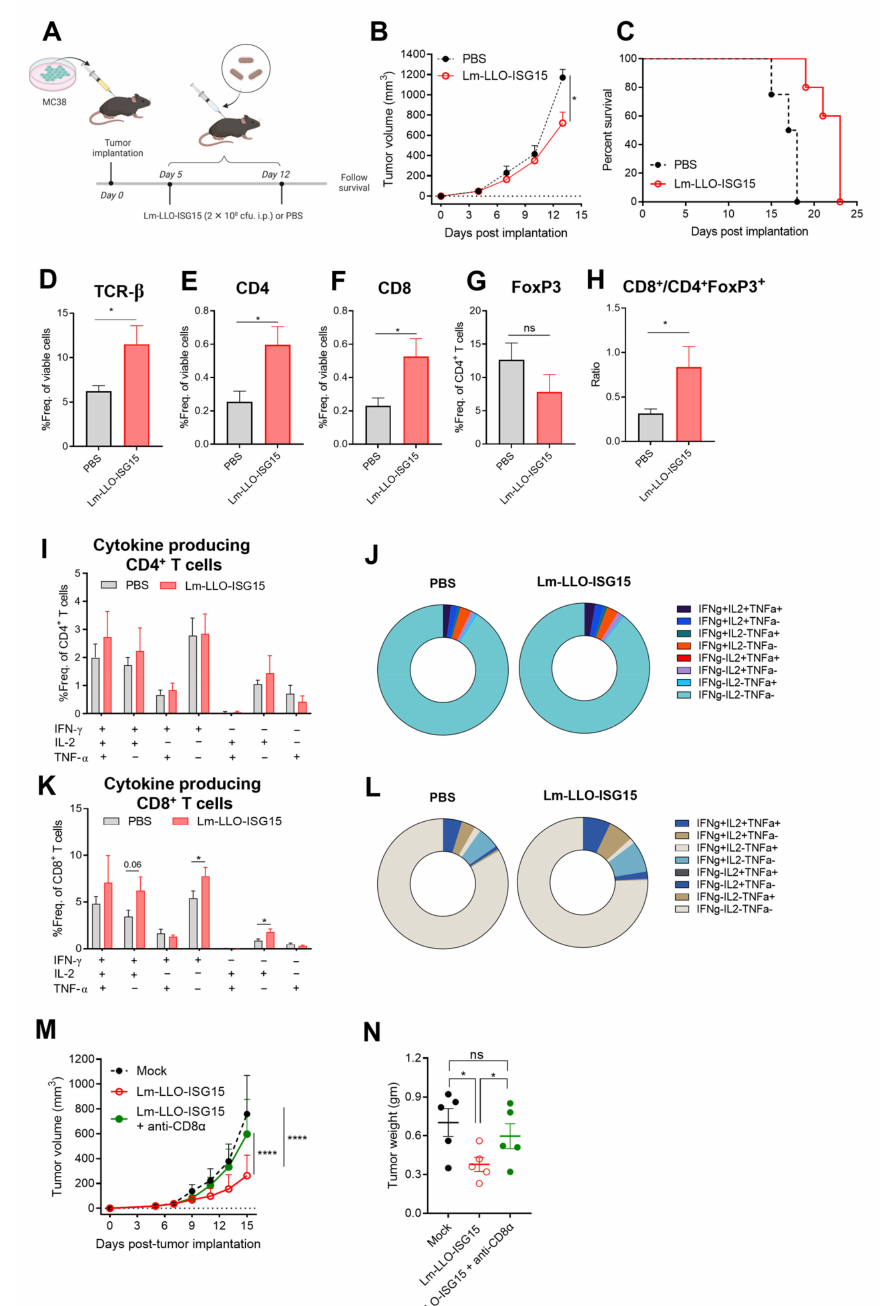
Figure 3. Lm-LLO-ISG15 vaccination results in anti-tumor efficacy in a subcutaneous CRC